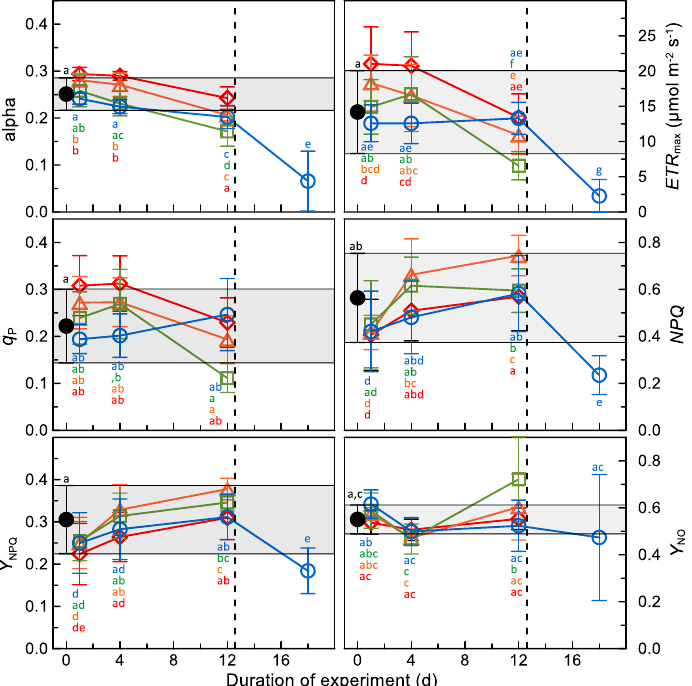
Figure 4. Means (±SD, n = 6) of the maximum photosynthetic quantum yield (α), the maximum li ght saturated electron transport rate ( ETR max ), the photochemical quenching coefficient ( q P ), the non-photochemical quenching ( NPQ ), and the quantum yields of regulated ( Y NPQ ) and non-regulated non-photochemical energy loss in PSII ( Y NO ) of banana fruit measured by rapid light curves ( max PFR = 235 µmol m −2 s −1 ) with PAM fluorometers during cold storage ( circles: 5 °C; squares: 10 °C; Δ triangles: 11.5 °C; diamonds: 13 °C) and shelf life. The vertical dashed line indicates the end of cold storage on day 12 of the experiment. The filled circles reflect the means (the grey horizontal bar shows the respective SD) of all bananas ( n = 76), measured before storage. Different small letters indicate significant ( p < 0.05) differences between means.